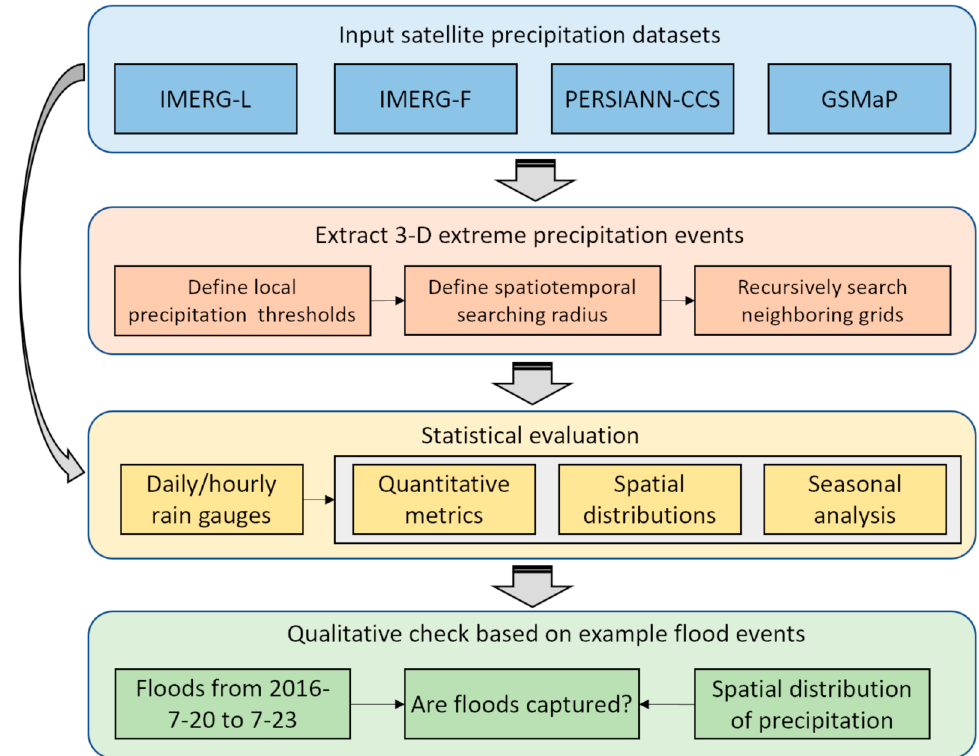
Figure 2. Technical flow chart of article